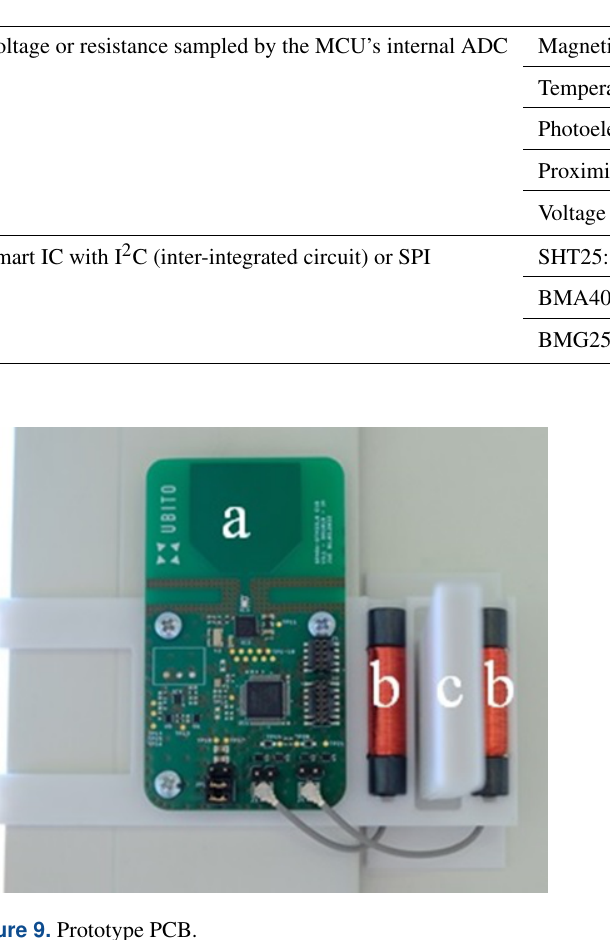
Figure 9. Prototype